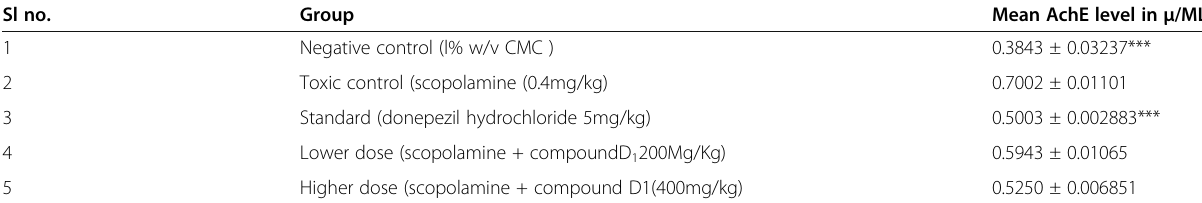
Table 3 Effect of compound D1 on brain acetylcholine esterase level Sl